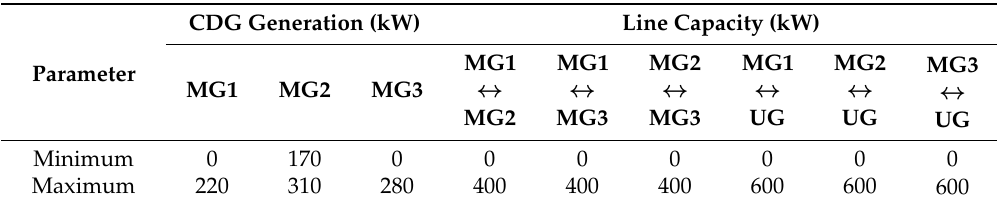
Table 4. Parameters related to controllable distributed generators (CDGs) and line capacities of the network.